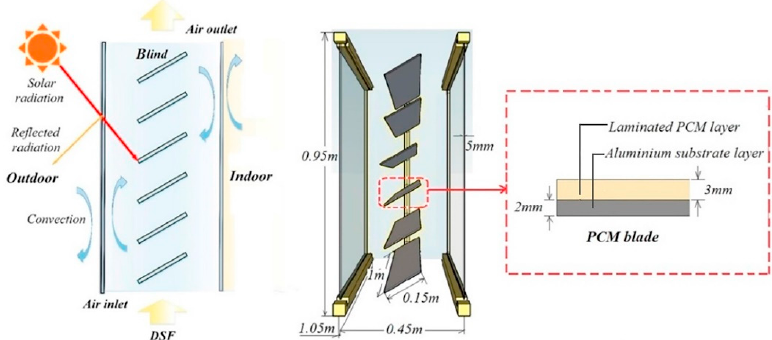
Figure 16. Schematic of experimental setup by Li et al. [54].